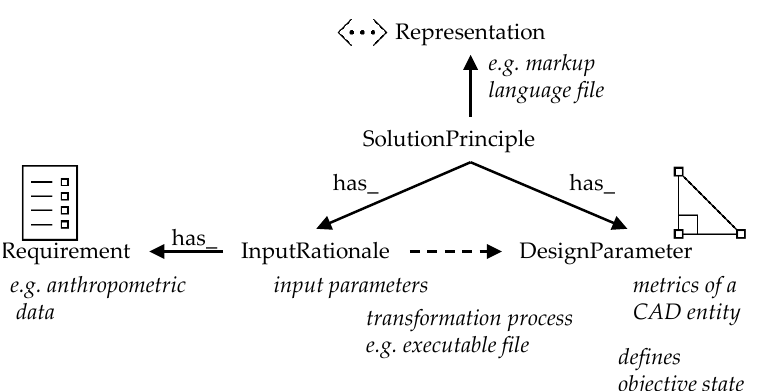
Figure 7. Illustration of the alignment of SeEDMC’s concepts to other knowledge